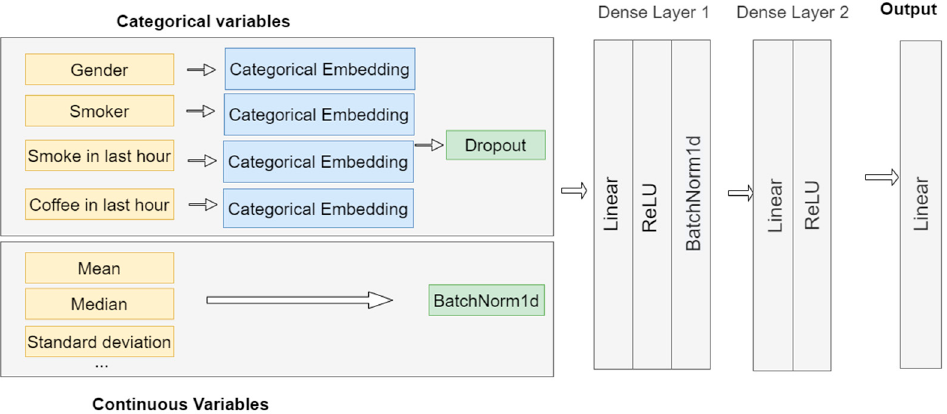
Figure 1. A visualization of the neural network (deep-learning model) architecture and training process. Continuous and categorical variables (left part) are combined in order to feed 2 interconnected hidden layers (dense 1 and 2).